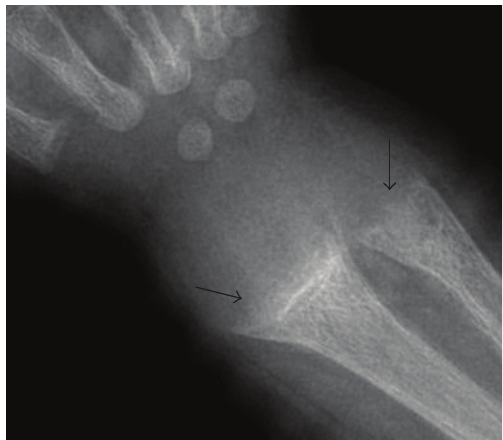
Figure 2: Wrist radiograph of the same patient as Figure 1. The distal metaphysis of the radius and ulna is widened and frayed with a mild cupped configuration (arrows).